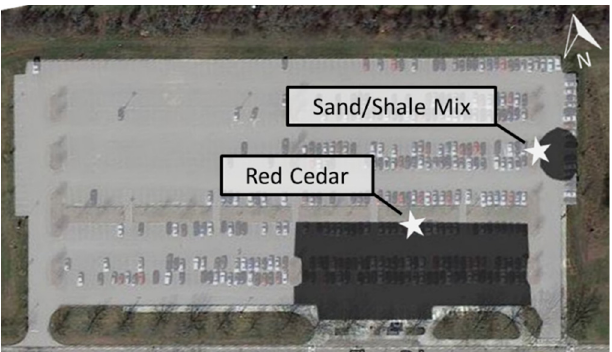
Figure 1. Overview of the parking lot where the two tree filter (TF) units are installed. The stars denote the location of the tree filter. The contributing areas of both filters are outlined in dark grey; for the sand/shale mix TF the contributing area is 238 m 2 or 0.06 acres and for the innovative TF (ITF) the contributing area is 2978 m 2 or 0.74 acres; however, a drain exists adjacent to the tree filter, thus capturing at least half of the runoff.